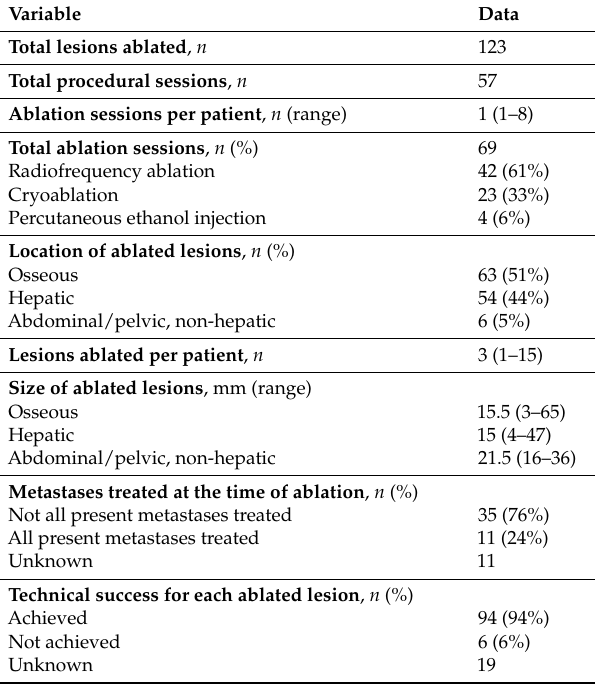
Table 2. Therapeutic approaches and outcomes in patients with metastatic pheochromocytoma and paraganglioma. Categorical data presented as absolute and relative frequencies (percentages). Continuous data presented as median (minimum–maximum range). Abbreviations: mm,